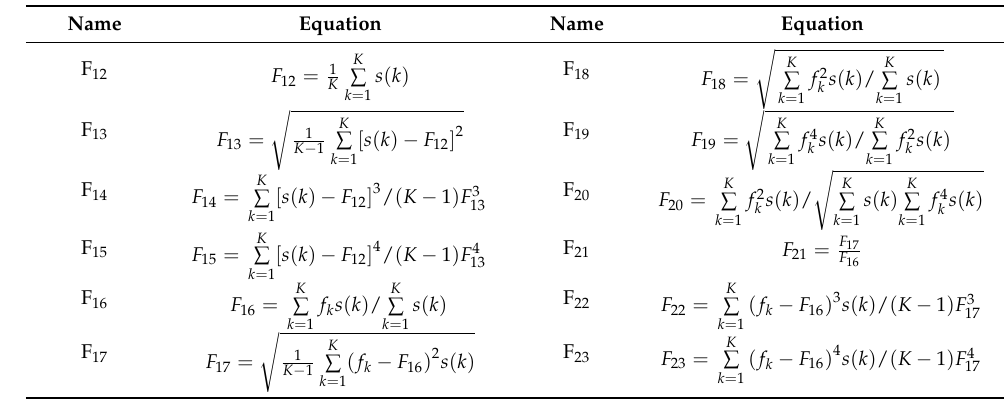
Figure 21. Fluctuations of frequency-domain indicators relative to the healthy condition for different crack degrees. Table 6. Frequency-domain statistical indicators.